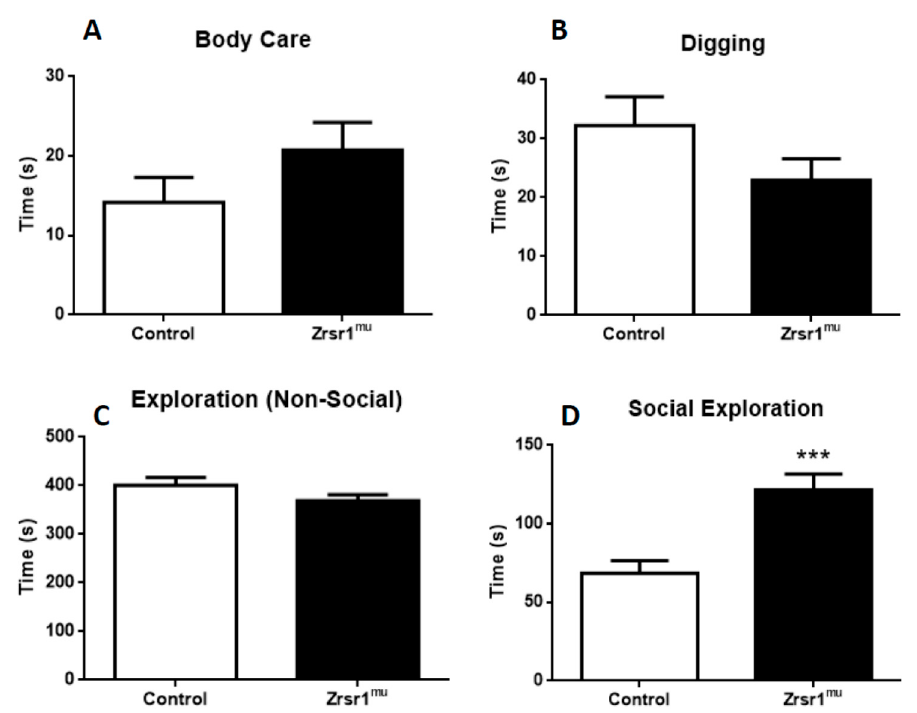
Figure 4. Performance in a social interaction test of male wild-type and Zrsr1 mu mice. Panels: ( A ) body care activity, ( B ) exploratory digging, ( C ) non-social exploration of the field, and ( D ) time spent in social exploration. Data are means ± SEM of at least 8 animals per group. *** p < 0.005.